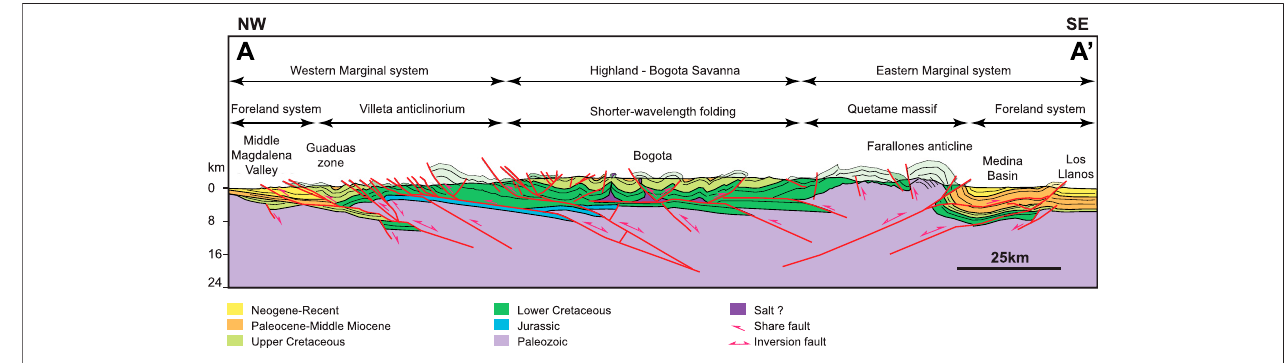
FIGURE 2 | Regional 2D structural cross-section along the Eastern Cordillera of Colombia (modi fi ed from Teixell et al., 2015). It is characterized by an overall symmetrical deformation with two marginal systems and a highland in the middle of the section (Bogota Savanna). The inversion-tectonic portion forms a thick-skinned system, whereas the foothill and foreland basin have experienced a thin-skinned